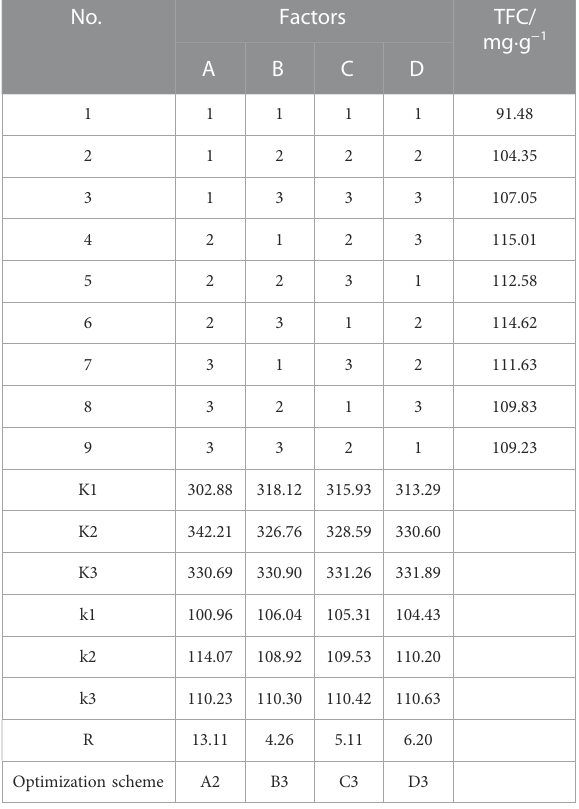
TABLE 3 TFC in C. retusa leaf extract obtained under the optimal